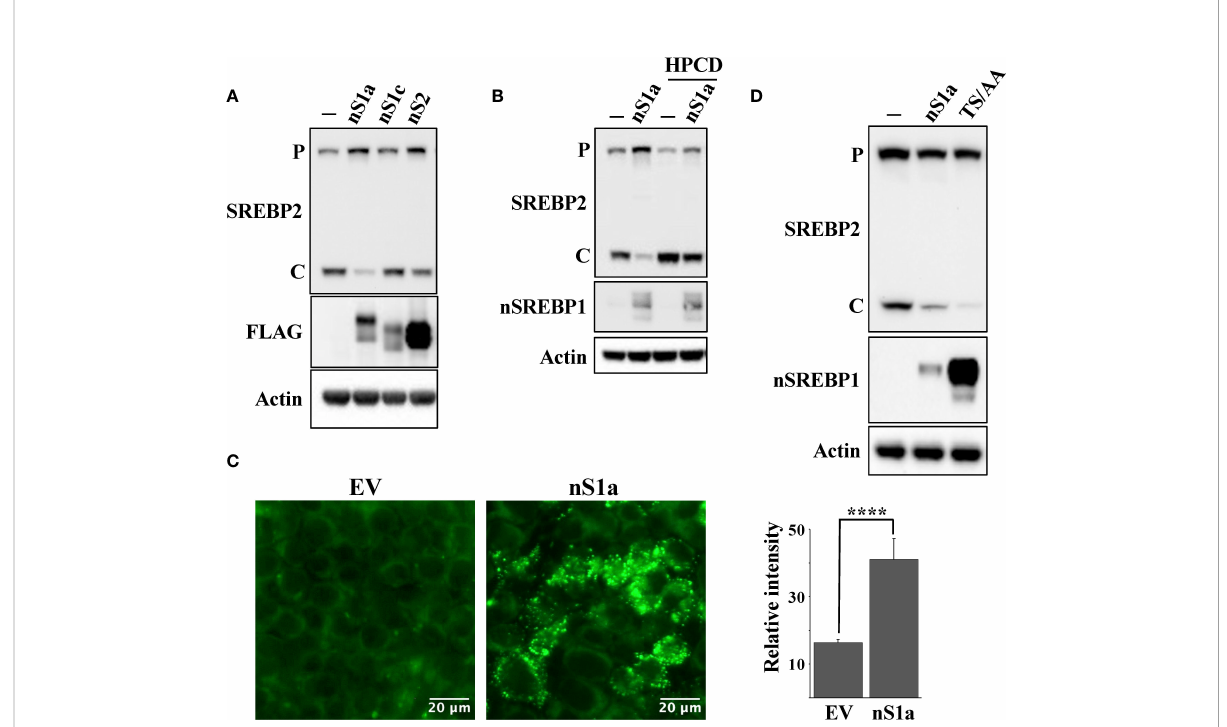
FIGURE 6 Nuclear SREBP1a attenuates the maturation of SREBP2. (A) HepG2 cells were transduced with GFP or the nuclear forms of SREBP1a (n S1a ), SREBP1c (n S1c ) or SREBP2 (n S2 ). The nuclear SREBP constructs contained a FLAG tag. The levels of endogenous SREBP2 and b -actin, and the transduced nuclear SREBPs ( FLAG ) in total lysates were determined by Western blotting. P and C denotes the precursor and cleaved forms of SREBP2, respectively. (B) HepG2 cells were transduced with GFP or the nuclear form of SREBP1a (n S1a ) and were left untreated (-) or treated ( + ) with HPCD for 2 hours. The levels of SREBP2, nuclear SREBP1 ( nSREBP1 ), and b -actin in total lysates were determined by Western blotting. P and C denotes the precursor and cleaved forms of SREBP2, respectively. ( C ) HepG2 cells were transduced with empty vector ( EV ) or nuclear SREBP1a ( nS1a ), fi xed and stained with LipidTOX Green neutral lipid stain. The mean fl uorescence intensities -/+ SD across each experimental group are provided in the bar graph. ( D ) HEK293 cells were transfected with empty vector, wild-type nuclear SREBP1a ( nS1a ) or a stabilized version of nuclear SREBP1a ( TS/AA ). The levels of endogenous SREBP2 and b -actin, and the transfected nuclear SREBP1a in total lysates were determined by Western blotting. P and C denotes the precursor and cleaved forms of SREBP2, respectively. Please note that the stabilized version of nuclear SREBP1a accumulates to much higher levels than the wild-type protein. P-values lower than 0.05 were considered statistically signi fi cant. *P < 0.05, **P < 0.01, ***P < 0.001, and ****P < 0.0001. NS , not signi fi